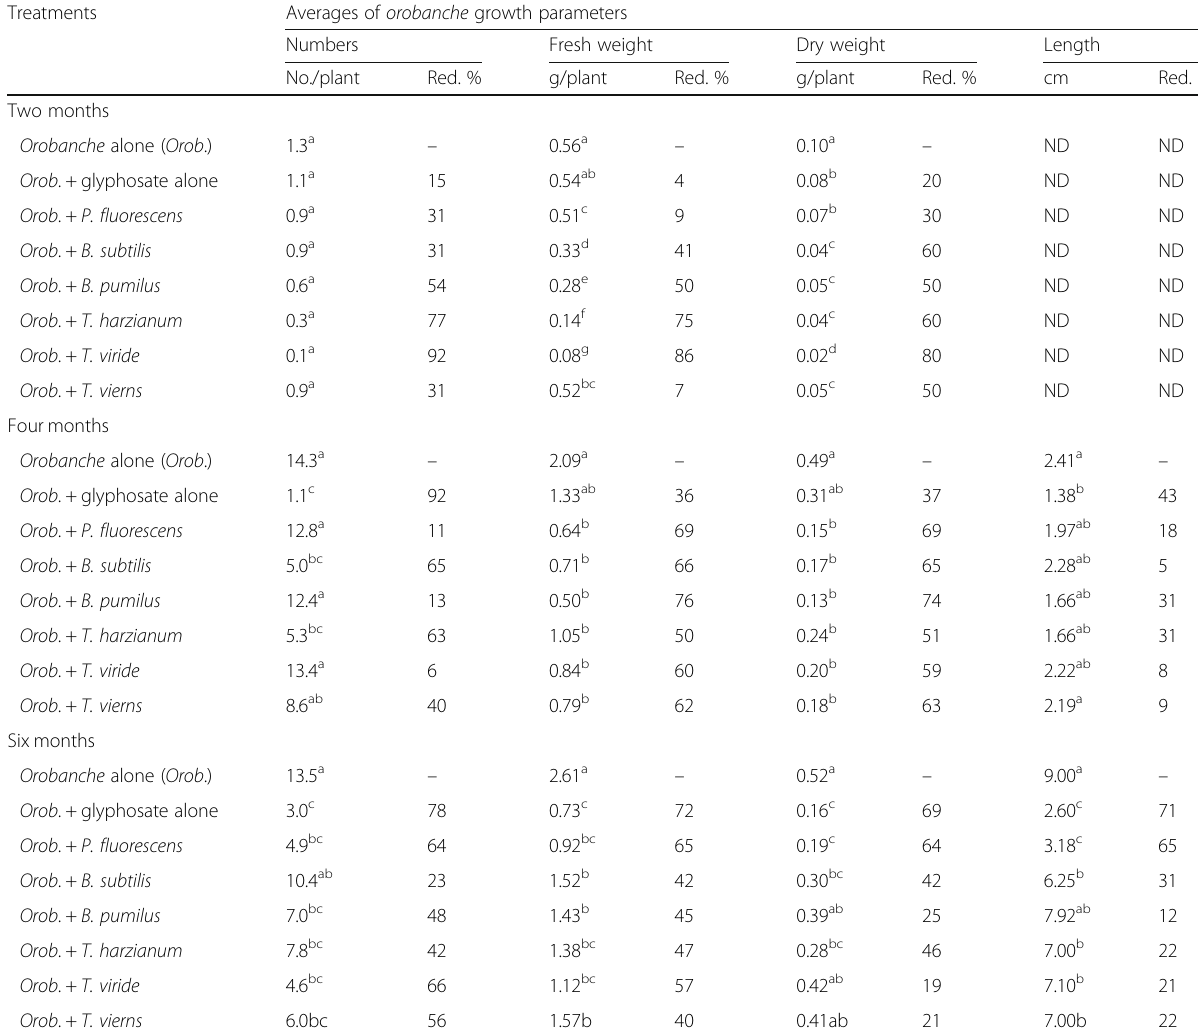
Table 4 Effects of plant growth-promoting bacteria and Trichoderma species on O. crenata growth parameters in faba bean under greenhouse conditions (Experiment III)